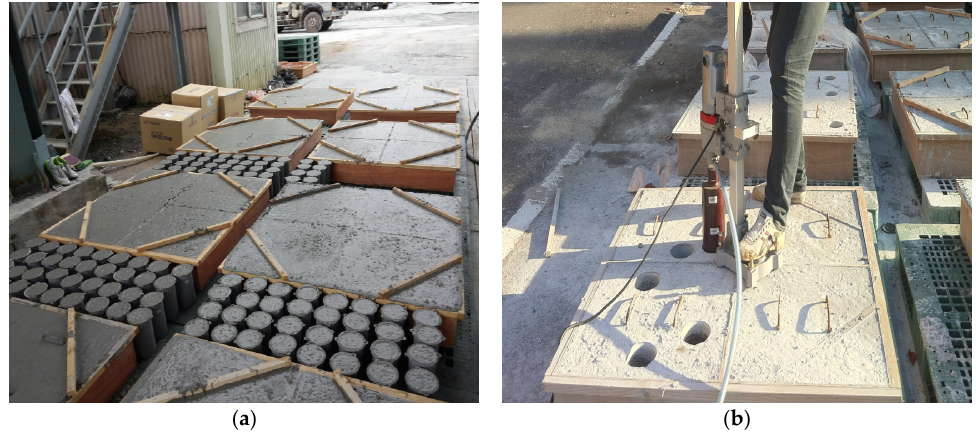
Figure 2. Fabrication of concrete cylinder specimens and concrete block for a core strength